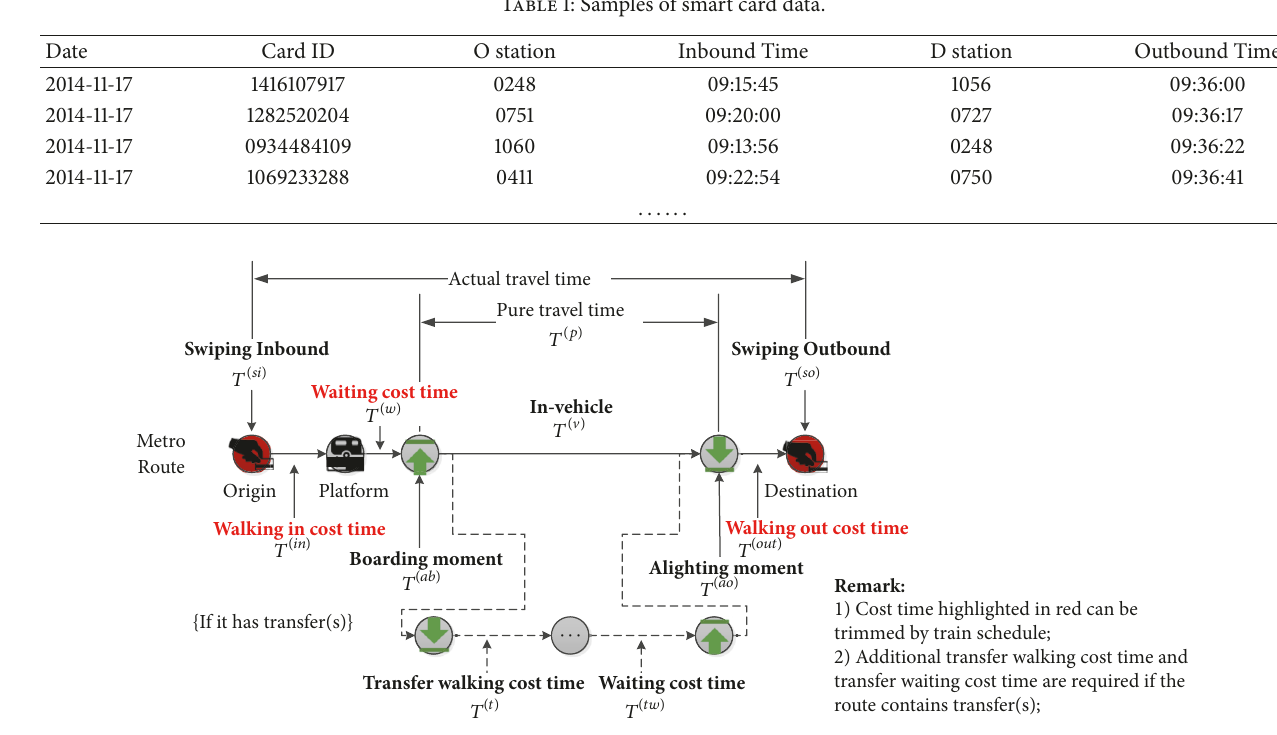
Figure 2: Passenger trip diagram by metro